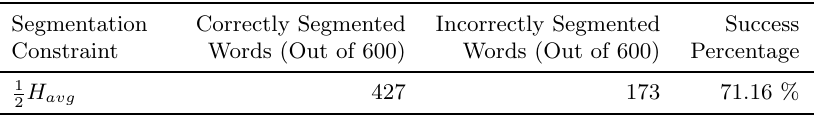
Table 2: Results of vertical segmentation